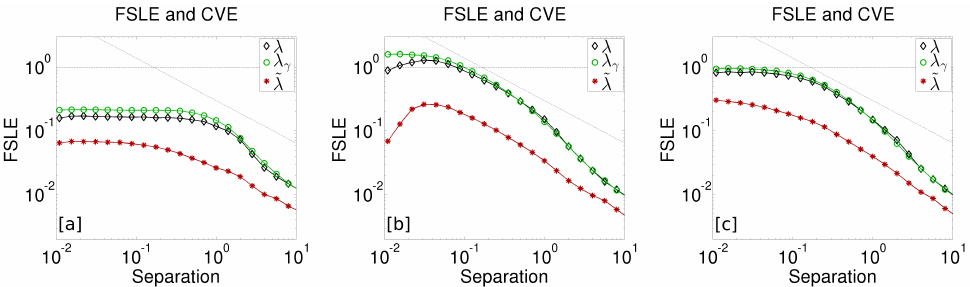
Figure 3. Comparison between the FSLE computed with Equation (30) ( λ γ , green circles), the FSLE computed from the pair separations using the first crossing time ( λ , black diamonds), and the CVE (˜ λ , red asterisks). The k − 2/3 slope is indicated by the dotted gray line. The panels correspond to the experiments A ( a ), B ( b ) and C ( c